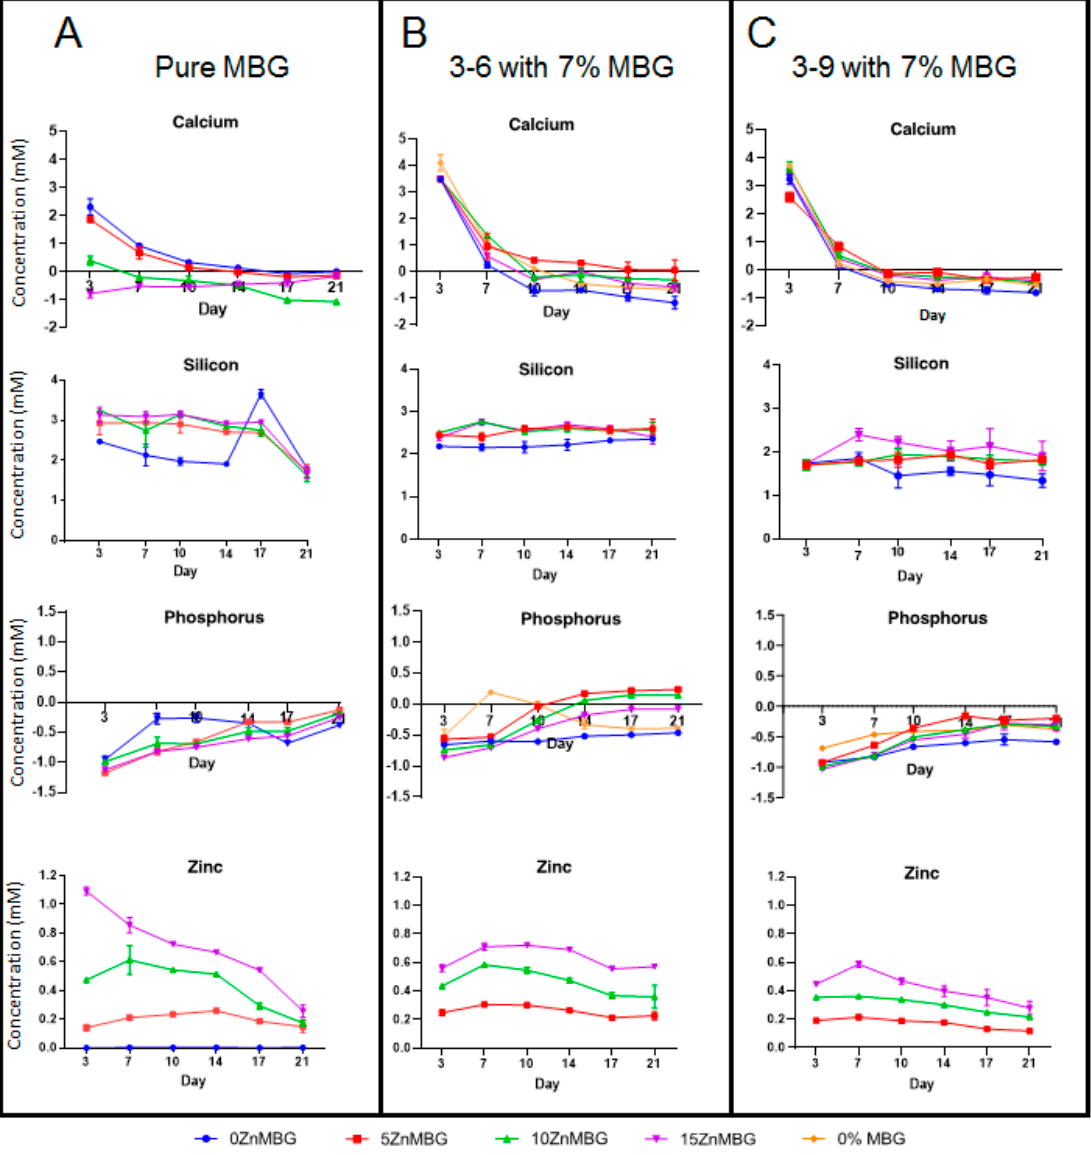
Figure 8. Release of different ions ( A ) from bulk MBG and ( B ) from cell-laden 3–6 and ( C ) 3–9 composite scaffolds containing 7% of each ZnMBG during 21 days; since no Zn was released from 0ZnMBG (blue line) and from 0% MBG (orange line) samples (data not shown), these values are not presented in ( B , C ). Values for released concentrations of Si from 0% MBG are not presented in ( B , C ) for the same reason. Values are means ± SD n = 3.